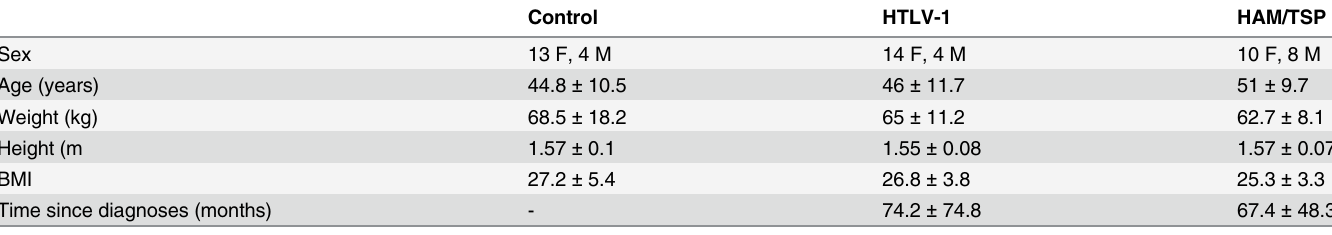
Table 1. Characteristics of the subjects in the three experimental